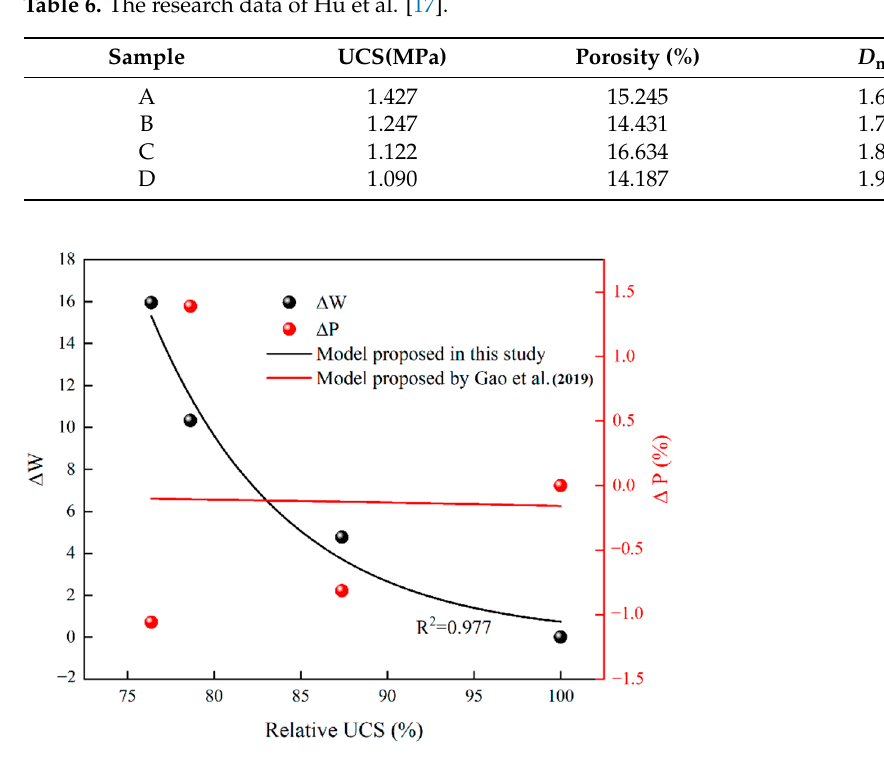
Figure 12. Prediction results of three models [29,35].